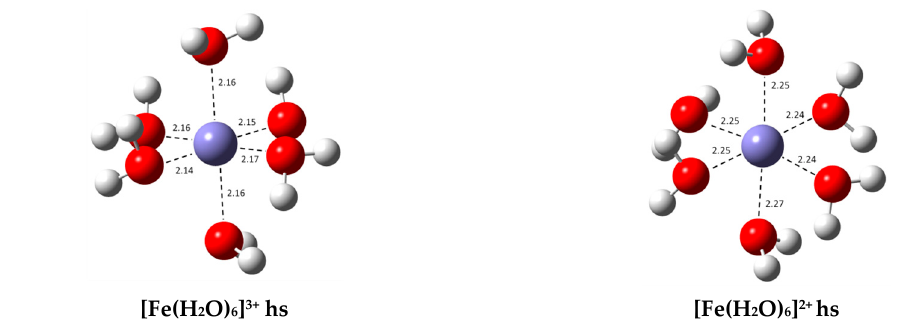
Figure 3. Optimized geometries of the most stable hydrated Fe(III) and Fe(II) complexes in aqueous solution (bond distances in Å); both complexes are high spin (hs).